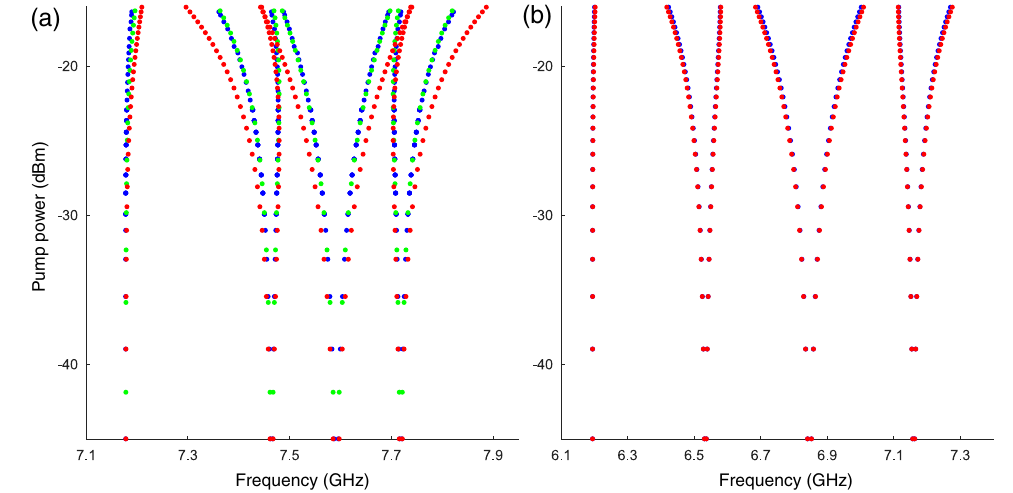
FIG. 9. Theoretical simulations of the emission spectrum for different pump powers. Here, the blue squares are numerical results obtained from the total Hamiltonian Eq. (E1), the green squares are from the dressed-transmon Hamiltonian Eq. (E2), and the red squares are from Eq. (E2) but with cos θ ¼ 1 . (a) Here, ω 01 ¼ 7 . 97 GHz, and the bound-state frequency is 7.591 GHz. Using the appropriately reduced matrix element (cos θ < 1 , blue squares) is crucial in obtaining accurate results using Eq. (E2). (b) Here, the bare qubit frequency of 7 GHz and the bound-state frequency of 6.847 GHz are both far from the band edge, so that cos θ ≈ 1 and the reduction in the matrix element can be neglected, so all three data sets lie on top of each